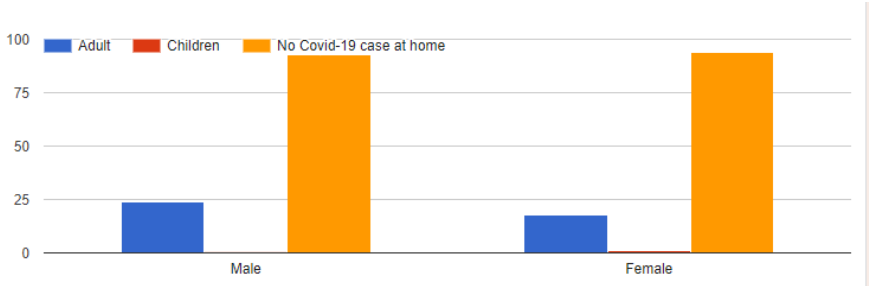
Figure 5: Number of Covid-19 Patients at Home (Source: Online survey)